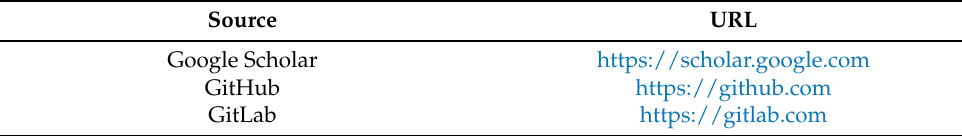
Table 1. Information sources used in this review and their respective URLs.